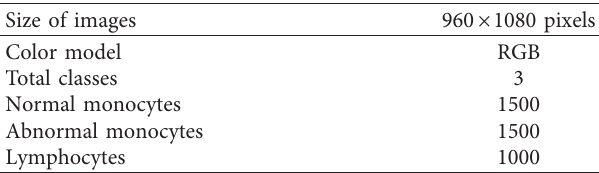
Table 1: Dataset